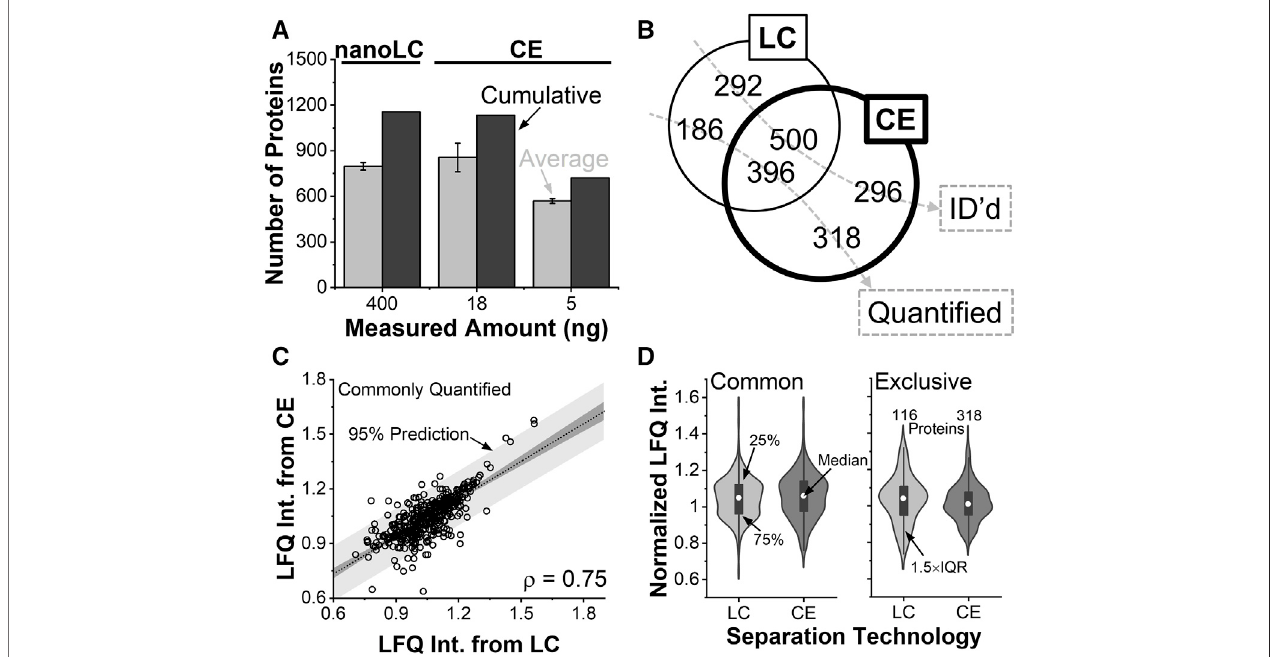
FIGURE3| Benchmarkingtheanalytical fi guresofmerit. (A) Proteinidenti fi cationsintheV12 X.laevis cellfrom~400 ngofproteindigestbynanoLCand~18 ngof protein digest by CE HRMS. (B) Single-shot analyses identifying (ID) complementary types of proteins. The CE experiment quanti fi ed more proteins than nanoLC. (C) Pearson correlation analysisofproteins that werequanti fi able byboth technologies. (D) Statistical comparison ofprotein quanti fi cation (Wilcoxon signed tests)revealing indistinguishable abundance distribution for commonly quanti fi ed proteins. Proteins that were only quanti fi able by CE were detected in statistically higher